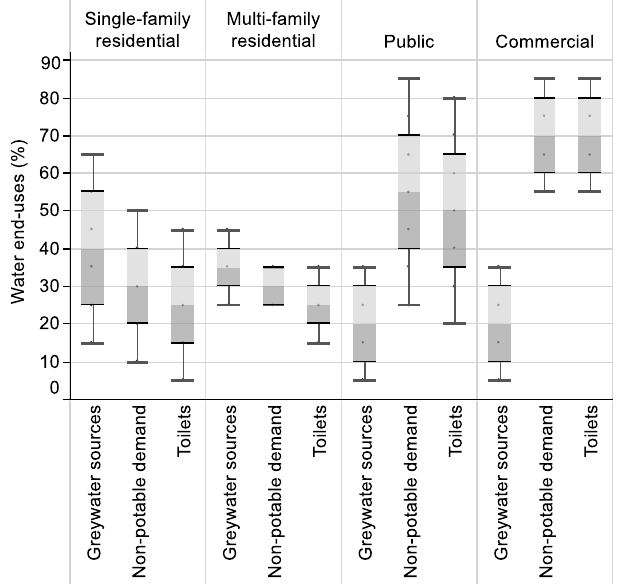
Figure 2. Range of water end-use scenarios for each building